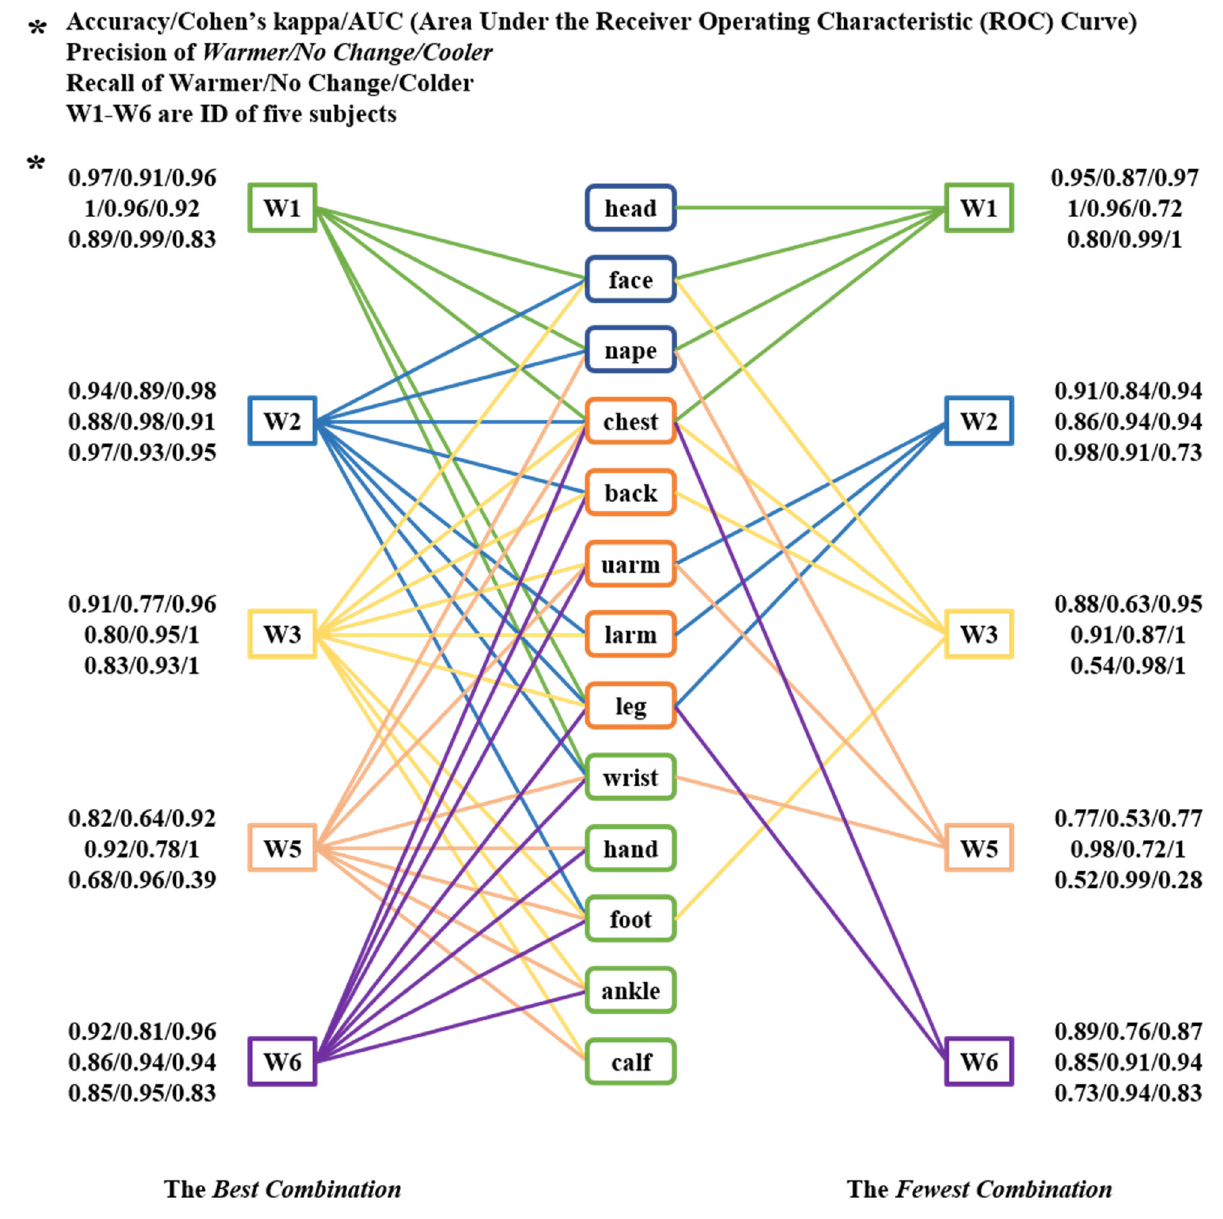
Figure 10. The best combination and fewest combination of each subject.